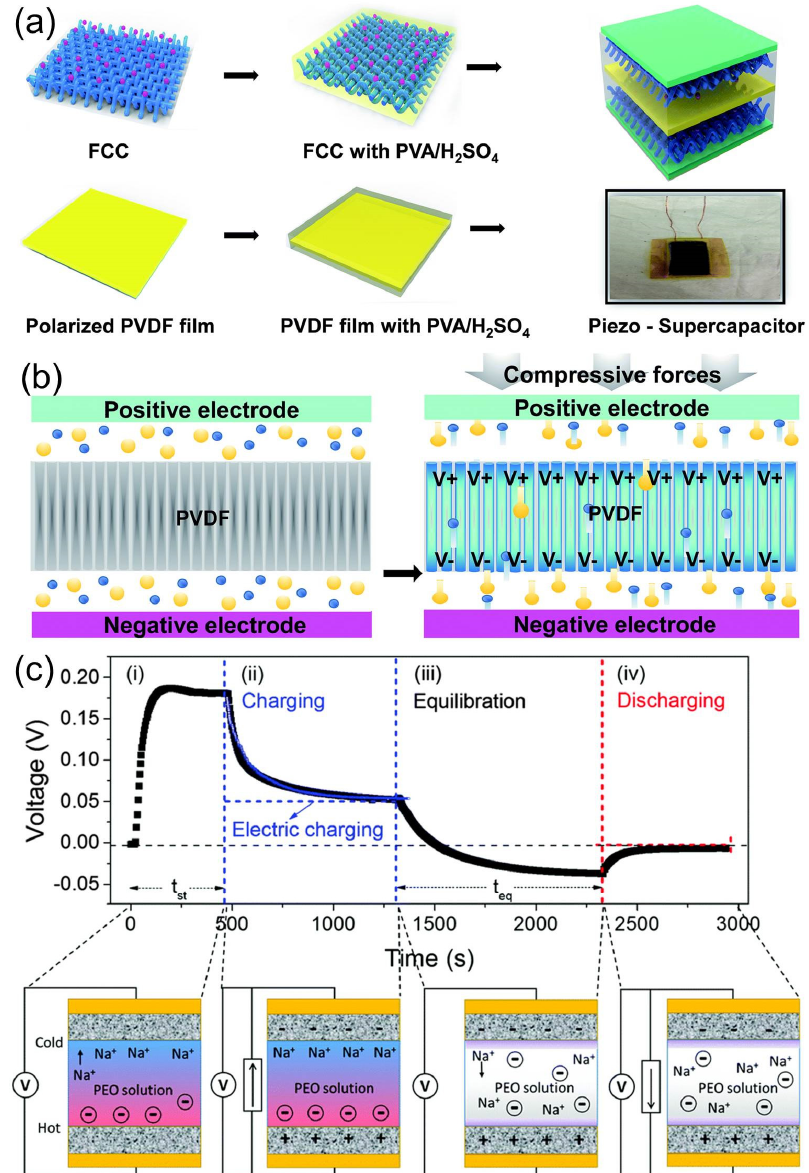
Figure 12. ( a ) Fabrication and ( b ) working mechanism of piezoelectric-based self-charging su- percapacitor composed of PVDF film and PVA/H 2 SO 4 polymer electrolyte over the carbon cloth substrate [186]. ( c ) Galvanostatic charge–discharge profile (at different conditions such as (i) initial, (ii) charging, (iii) equilibration & (iv) discharging stages) and the working mechanism of thermoelectric- based self-charging supercapacitor fabricated from the polyethylene oxide-sodium hydroxide elec- trolyte and CNT-based electrode materials [188].